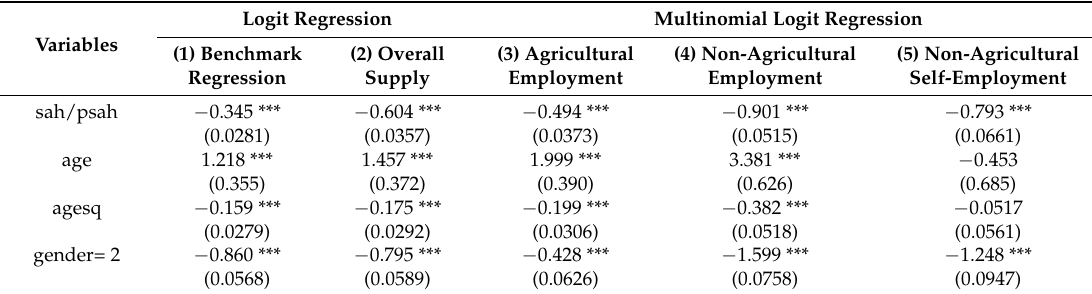
Table 2. The regression results of LFP of rural elderly